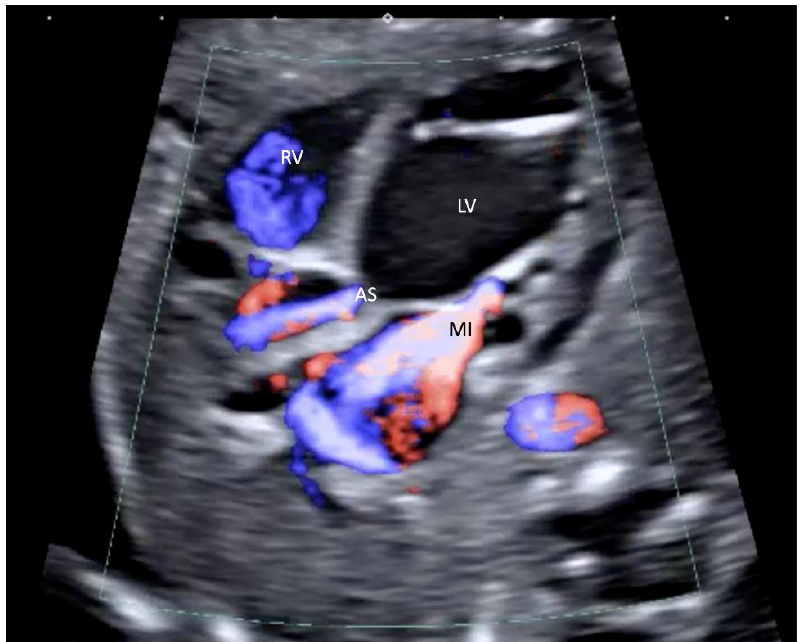
Figure 1. Left outflow tract in a fetus with severe aortic stenosis (AS) at 24 + 2 weeks of gestation. Color Doppler demonstrates a high velocity jet over the aortic valve and massive mitral insufficiency (MI) LV, left ventricle; RV, right ventricle.